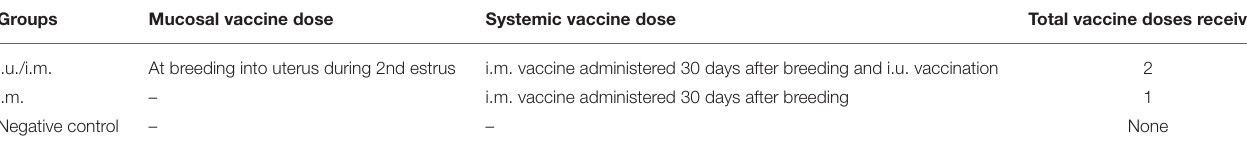
TABLE 2 | Schematic of vaccination schedule.